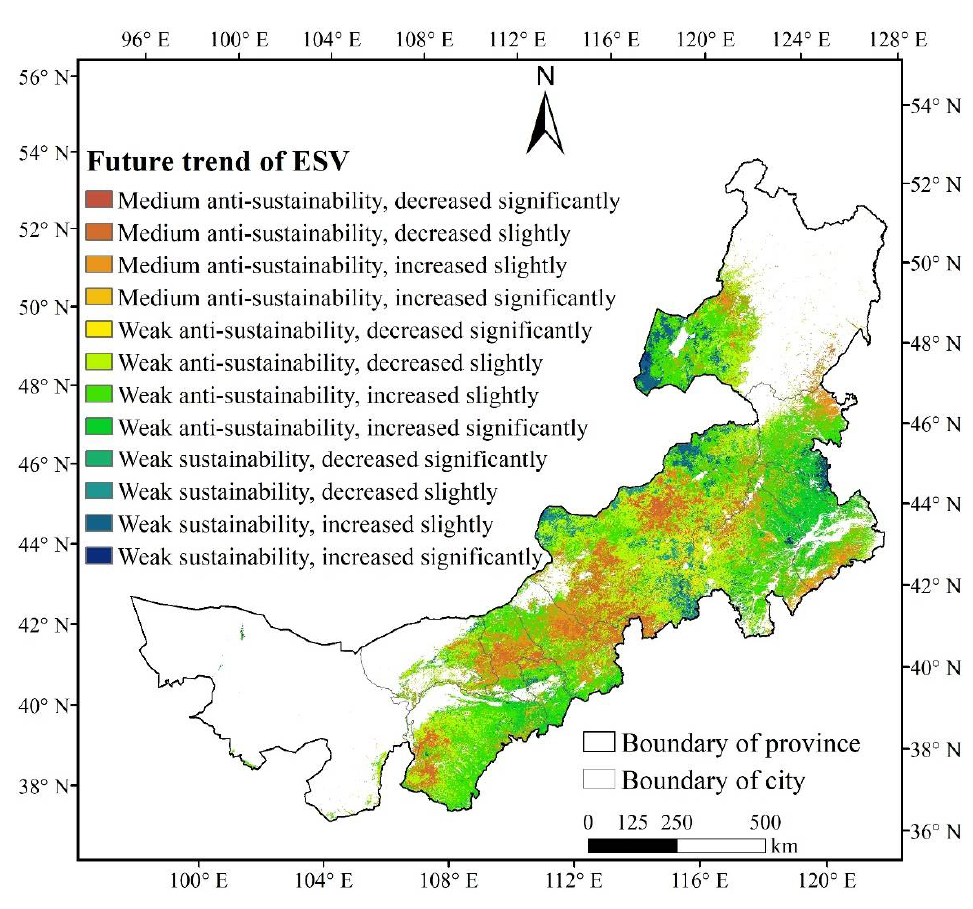
Figure 8. Future trends of grassland ESV in Inner Mongolia.